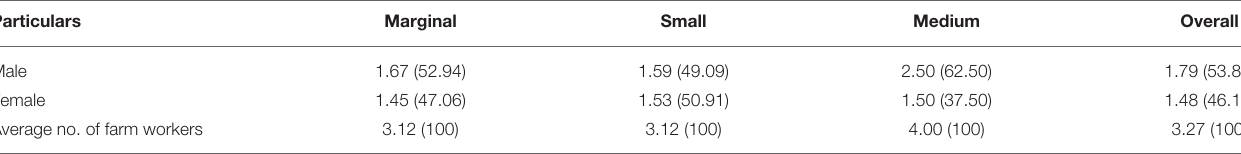
TABLE 6 | Gender-wise distribution of the farm workers in the sampled households (No.).